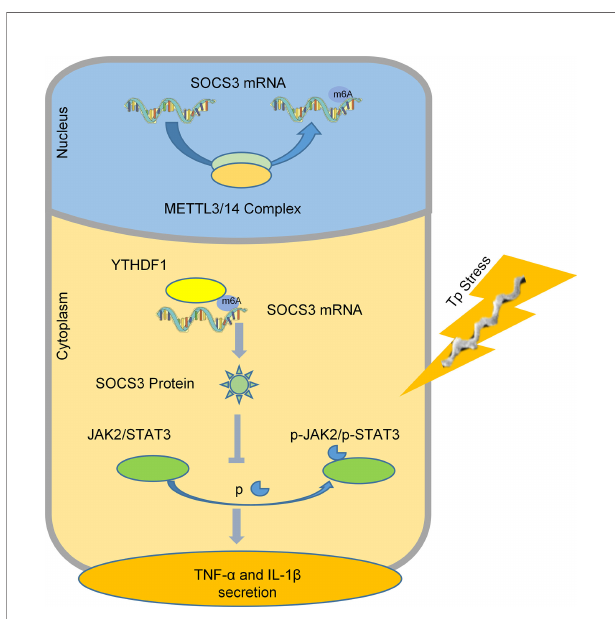
FIGURE 6 | A schematic diagram revealing the proposed mechanism by which YTHDF1 mediates the protein expression of SOCS3 in an m6A- dependent manner and regulates the in fl ammatory response in macrophages infected with